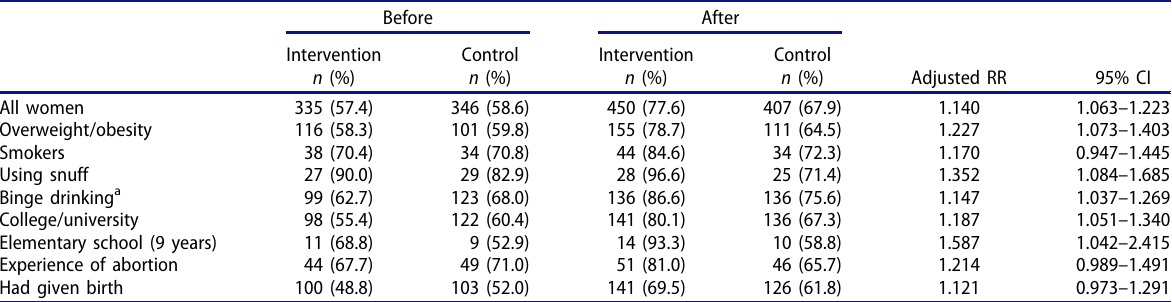
Table 5. Imagine that you want to get pregnant. Would you take any action before trying to conceive to increase the chances of having a healthy pregnancy and healthy child? Women who answered ‘ yes ’ before and after the intervention. Before